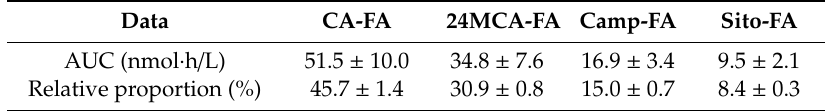
Table 1. The area under the plasma concentration-time curve (AUC; expressed as nmol · h / L) and relative to the proportion of OZ molecular species in plasma after RBOZ